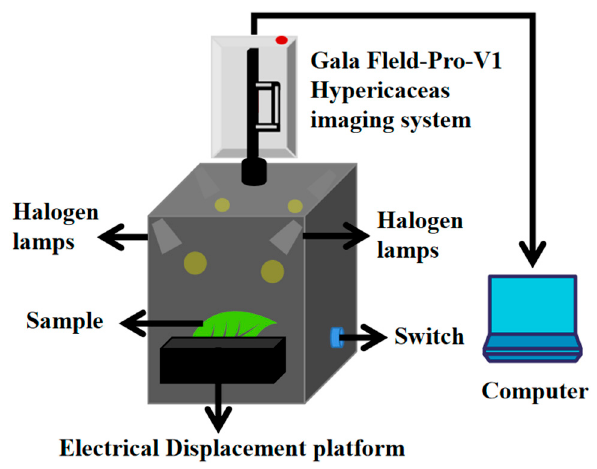
Figure 2. The hyperspectral imaging system.